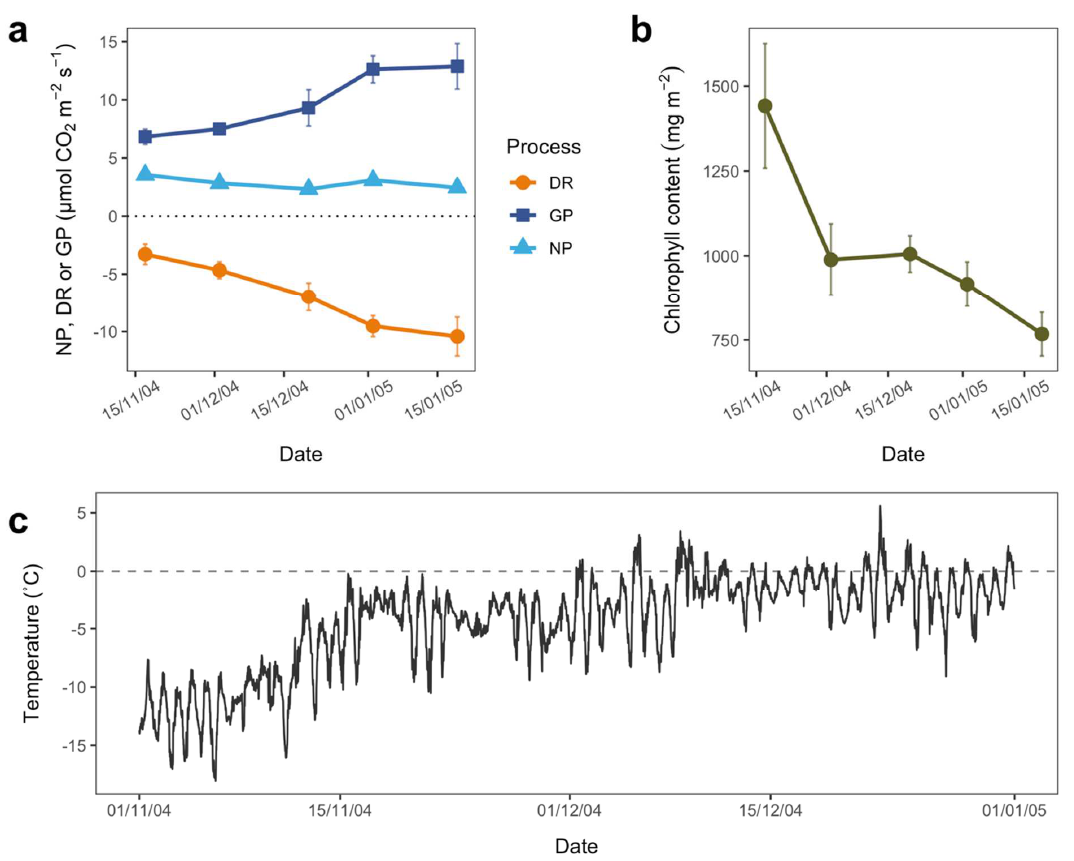
Figure 4. Physiological changes under ambient air temperatures in Bryum argenteum var. muticum across the Antarctic summer season November 2004 to January 2005. ( a ) changes in net photosyn- thesis (light blue ▲ ), gross photosynthesis (dark blue ■ ) and dark respiration (orange ). Shown are mean values ± SE for n = 5 samples; ( b ) changes in chlorophyll contents (mean values ± SE for n = 5 samples); ( c ) ambient air temperature at Cape Hallett during the summer season 2004. Temperature is recorded in °C at 15 min intervals.